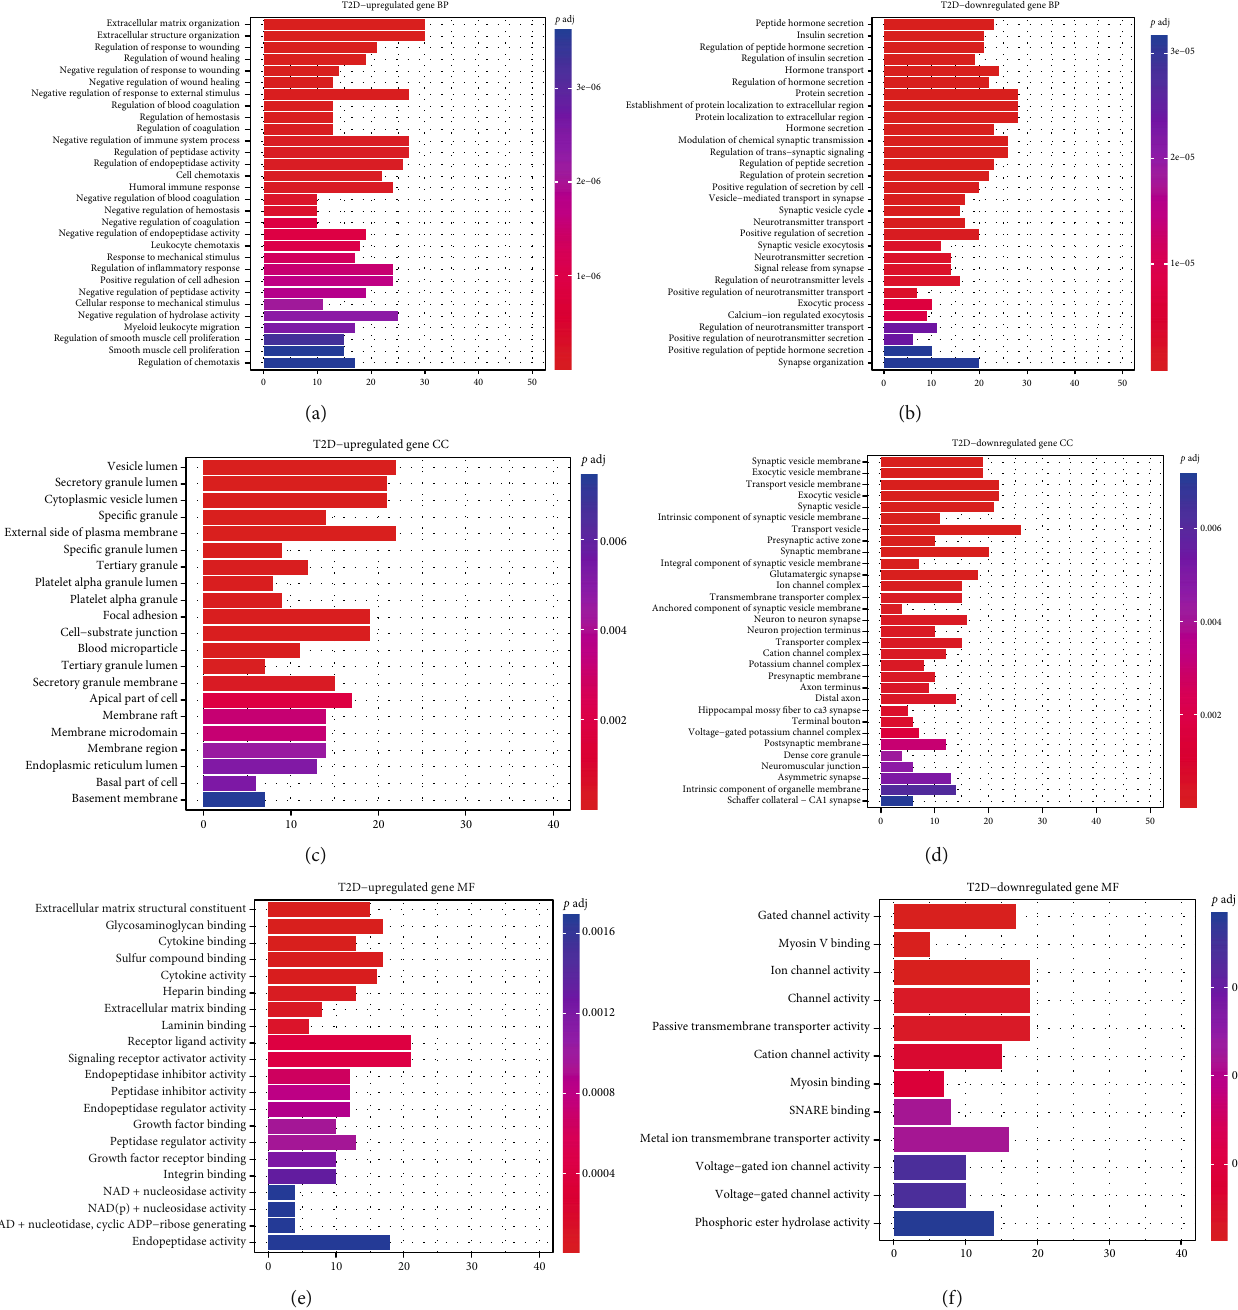
Figure 4: GO analysis of the up/downregulated DEGs involved in ND-T2D regarding biological process, cellular component, and molecular